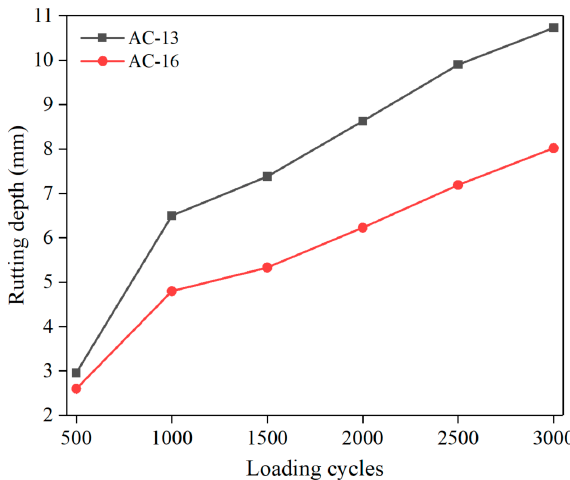
Figure 8. Rutting test